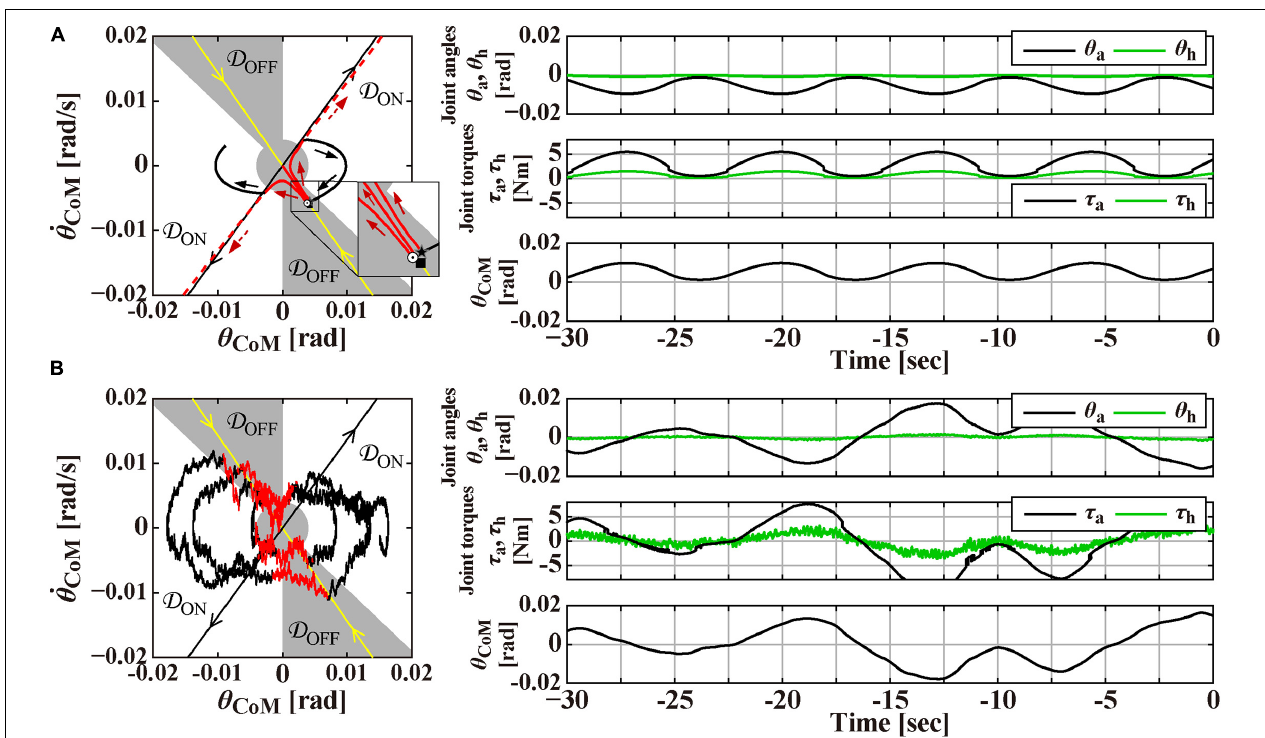
FIGURE 2 | Magnification of Figure 1 around the origin for the time interval of [–30, 0] s, prior to the perturbation-onset at t = 0 s. One of the remarkable features of the intermittent control model is that the postural state point (cid:0) θ CoM , ˙ θ CoM (cid:1) T is not in a quiescent state even during quiet stance in the absence of noise as in panel (A) , but it is oscillating periodically with a small amplitude of tilt angle about 0.01 rad, as confirmed by a closed trajectory (limit cycle) on the θ CoM − ˙ θ CoM plane. Panel (B) is the case with small Gaussian white noise as a motor noise. Panels on the right-hand side of the phase planes are the corresponding waveforms of θ a and θ h , the corresponding joint torques, and the tilt angle θ CoM . See text for